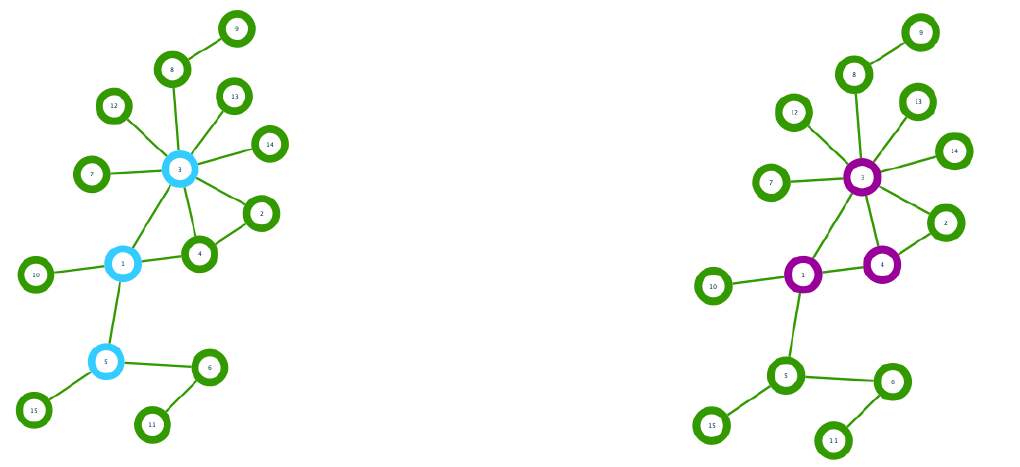
Figure 7. Scale-free network with N = 15 and d = 3. In cyan, the first 3 places generated by DIL-W 1 ranking. In purple, the first 3 places generated by Strength